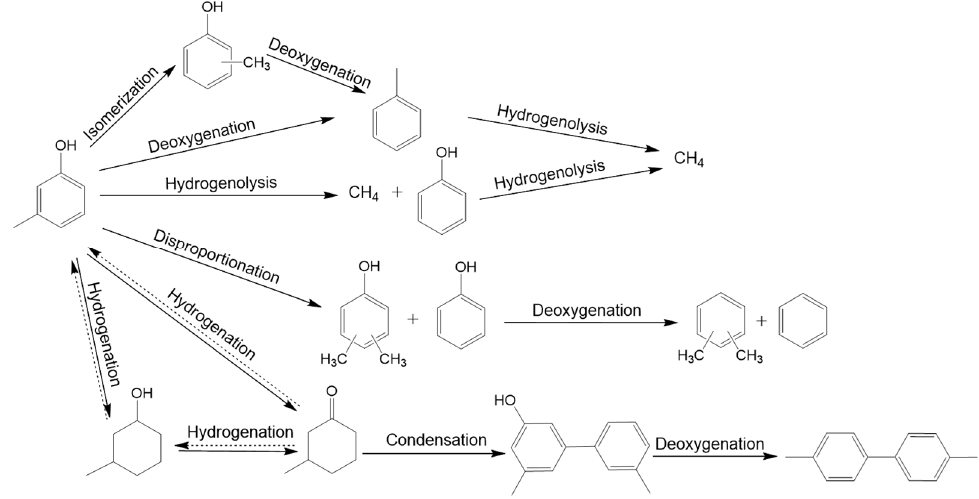
Figure 9. Proposed major reaction pathway during hydrodeoxygenation on Ni/r-TiO 2 catalysts. Table 4. Product yields at near-complete conversion of m-cresol over 1Ni/r-TiO 2 , 5Ni/r-TiO 2 , and 10Ni/r-TiO 2